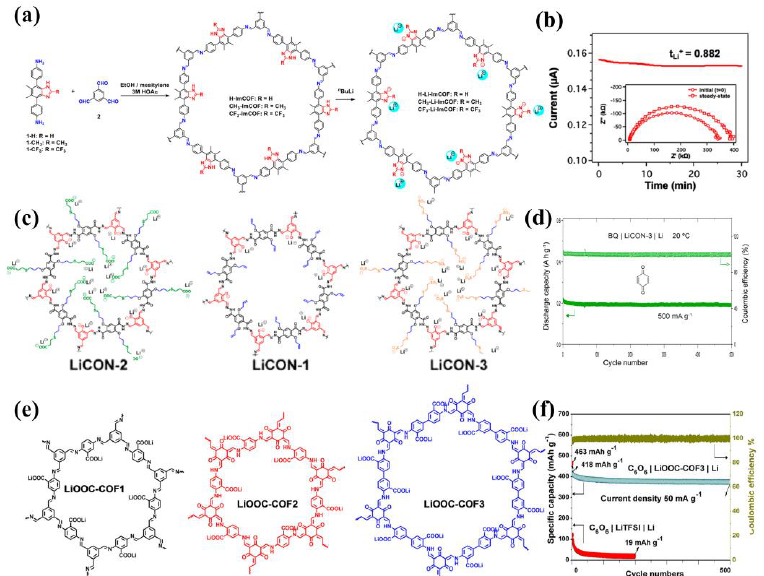
Figure 13. ( a ) Synthesis and structure of Li − ImCOFs; ( b ) lithium transference number calculated using the Bruce − Vincent − Evans technique. Reproduced with permission from Ref. [71], Copyright (2019), American Chemical Society; ( c ) Structure of LiCON; ( d ) Cycling performance of BQ|LiCON − 3|Li cells. Reproduced with permission from Ref. [72], Copyright (2020), American Chemical Society; ( e ) Structure of LiOOC − COF; ( f ) cycling performance of the C 6 O 6 |Li- OOC − COF 3 |Li battery at a current density of 50 mA g −1 [73]. Ref. [73] is an open-access article dis-